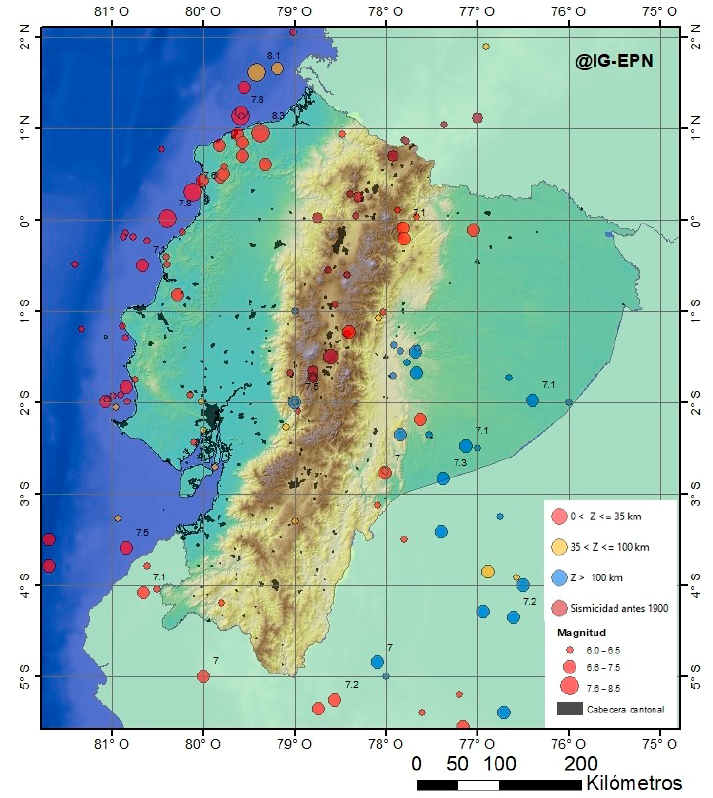
Figure 2. Seismicity of Ecuador with modification in recent years from [14]. The Ecuadorian Institute of Geophysics shows, as one of its products, the map with the geographic distribution of the last earthquakes in Ecuador greater than 6 MW. In this map, it can be seen that the seismic events with the greatest magnitude are concentrated on the Ecuadorian